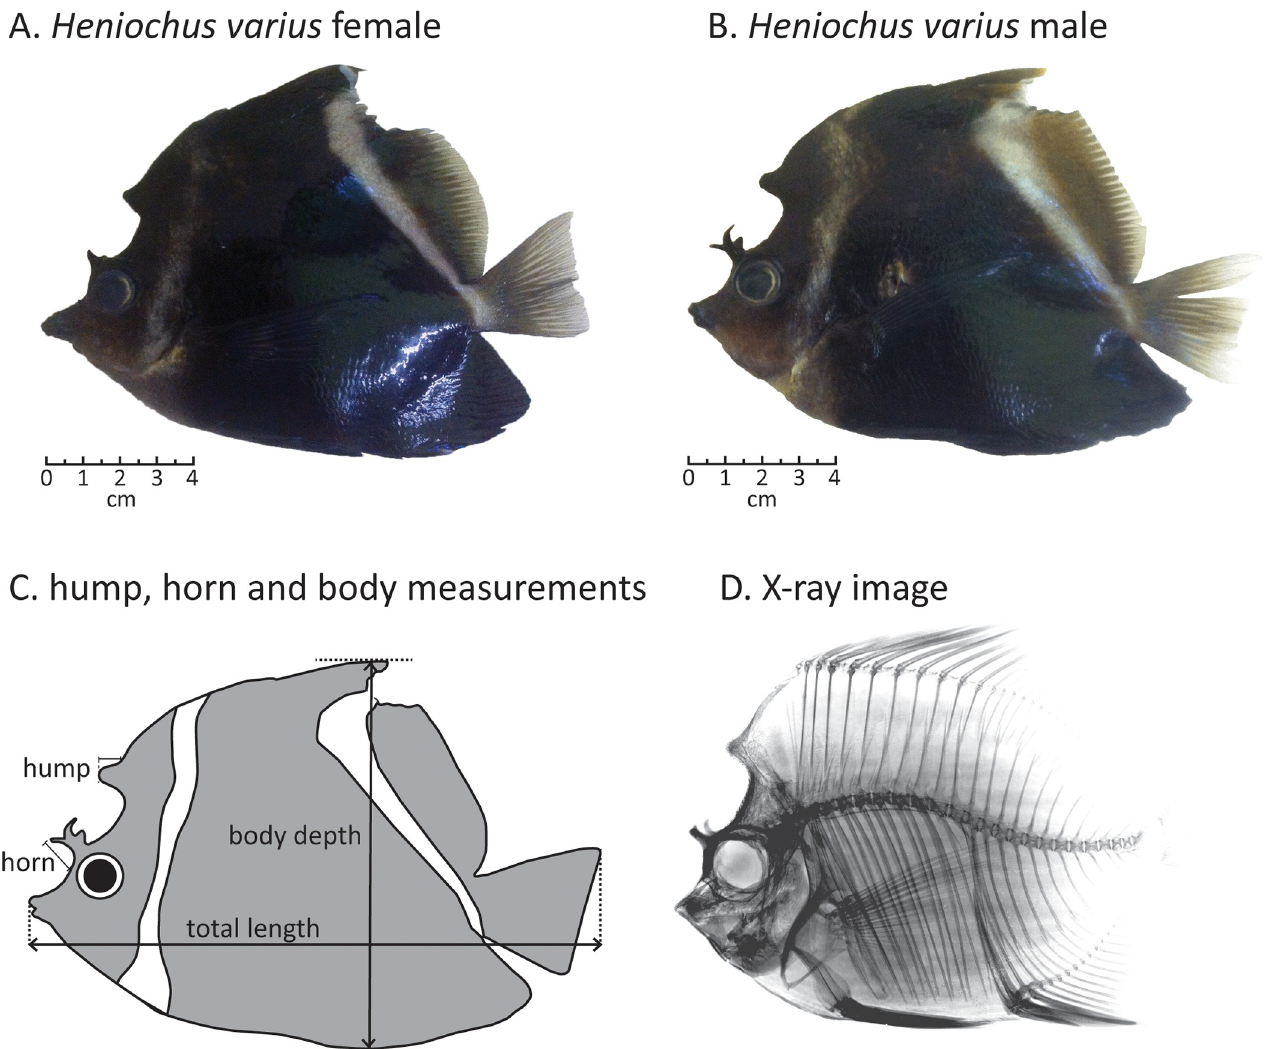
Fig 1. Diagrams of Heniochus varius illustrating their cranial hump and horn structures. The first two images show sexual dimorphism between the female (A) and male (B) within a size assorted breeding pair. (C) Shows the size measurements taken. (D) Shows an X-ray image illustrating the internal structures of the hump and horn